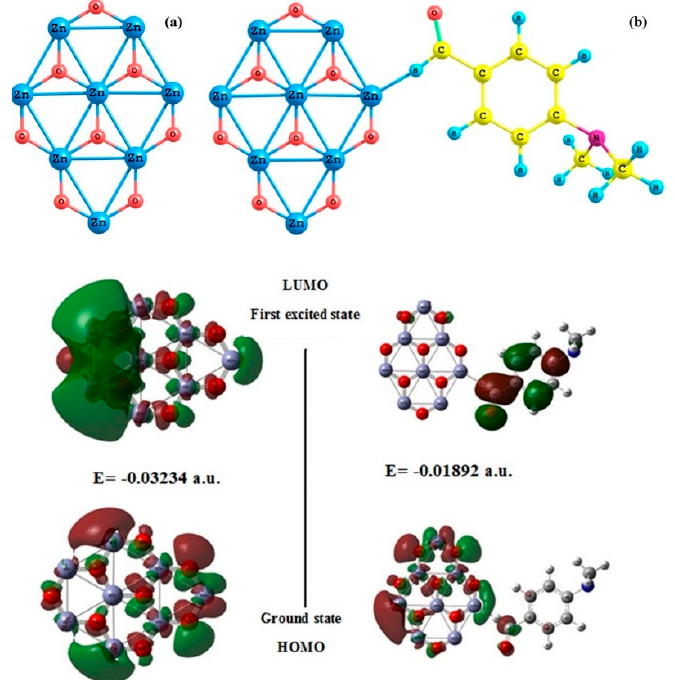
Figure 6. Structures of ( a ) Zn 8 O 8 and ( b ) Zn 8 O 8 :4DB clusters and energy gaps of frontier molecular orbitals of the Zn 8 O 8 and Zn 8 O 8 :4DB clusters.